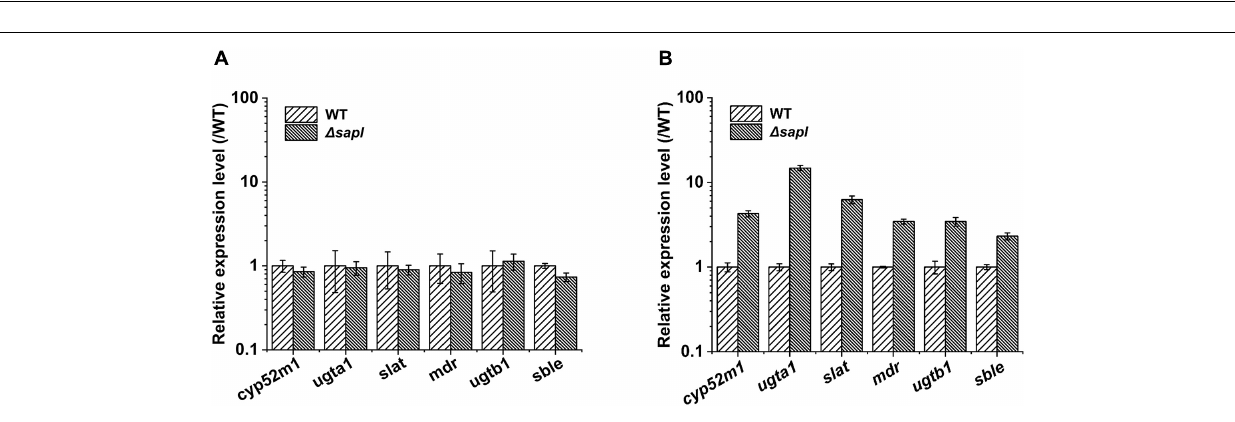
( Figure 4C ). The titer of total SLs of (cid:49) sapl increased from 60.71 to 75.11 g/L, and acidic SLs were the main contributors for the total SLs. With the fermentation period from 5 days to 7 days, the